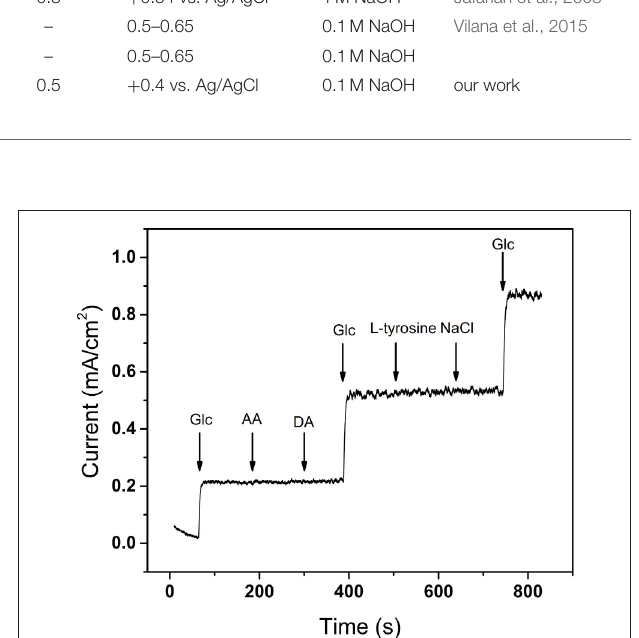
FIGURE 9 | Amperometric response of CoNiCu electrode to a successive addition of glucose and